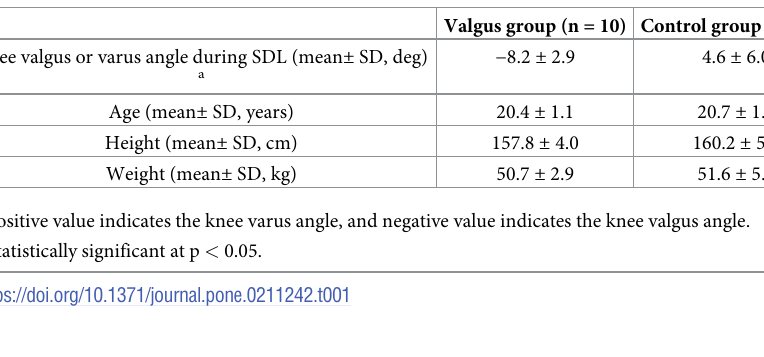
Table 1. The results of comparisons of participants’ characteristics, namely knee valgus or varus angle, age, height and weight, between valgus and control groups. Valgus group (n = 10) Control group (n = 18) p value Knee valgus or varus angle during SDL (mean ± SD, deg) a